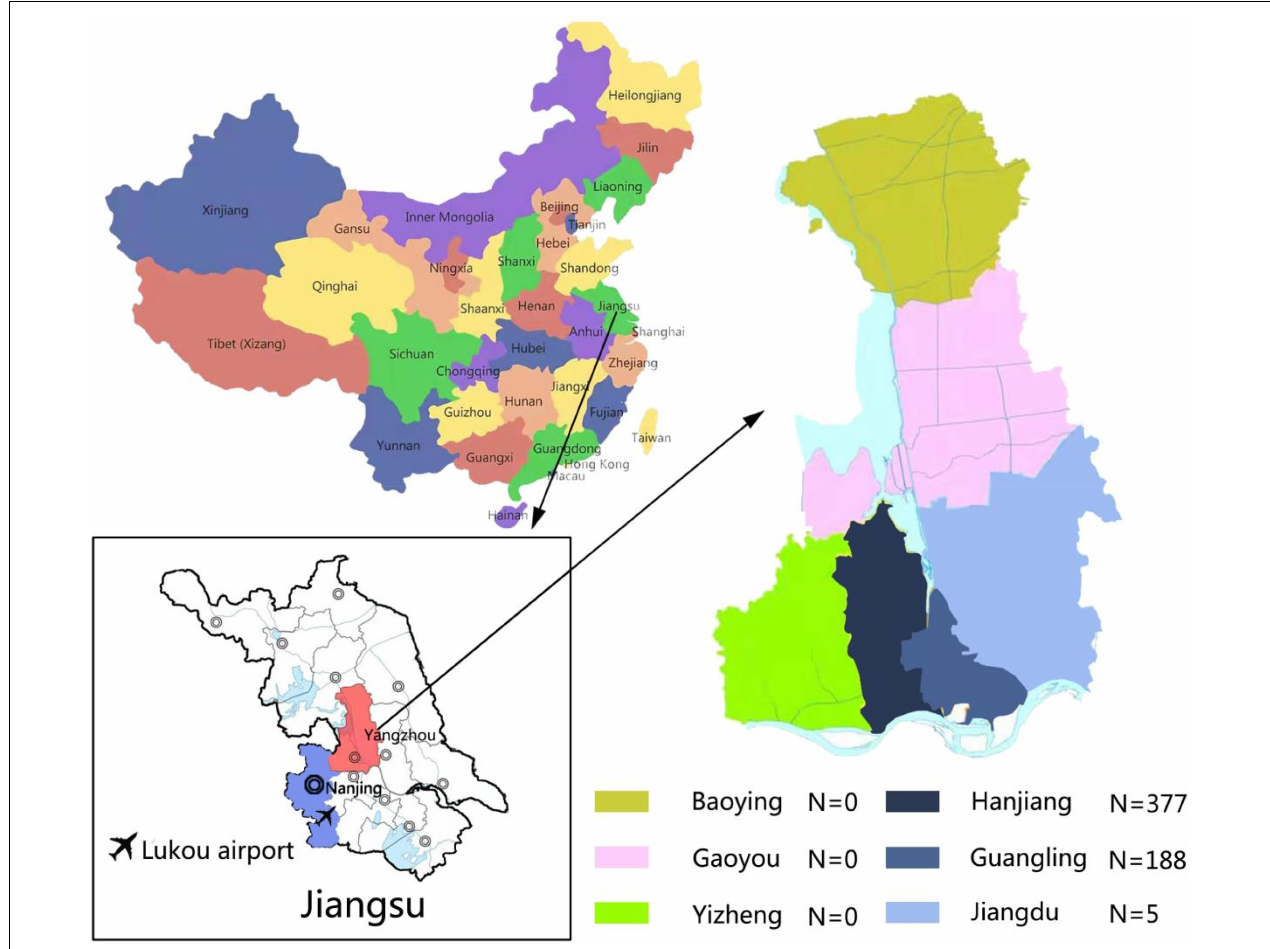
FIGURE 1 | Schematic illustration of the Yangzhou City geography and the corresponding distribution of confirmed cases in different districts of Yangzhou City. A total of six districts in Yangzhou City were present with confirmed COVID-19 cases, which were Baoying ( N = 0), Gaoyou ( N = 0), Yizheng ( N = 0), Hanjiang ( N = 377), Guangling ( N = 188), and Jiangdu ( N = 5).